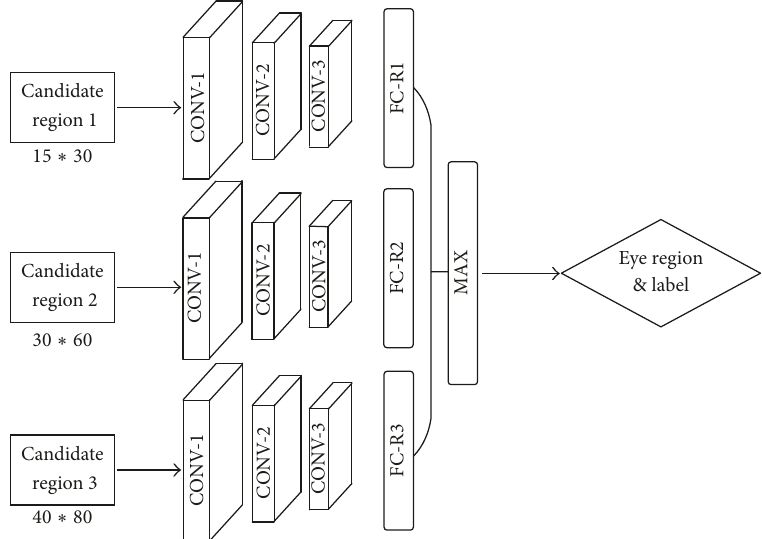
Figure 3: Structure of the 1st set of CNNs.